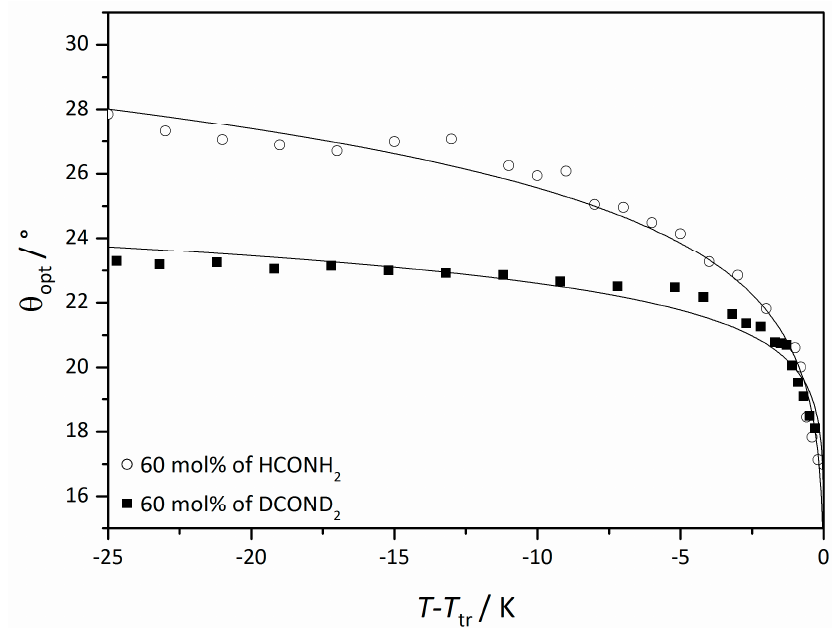
Figure 23. Optically measured tilt angle of the system 4 /formamide (circles) and 4 /deuterated formamide (squares) at the same mole fraction relative to the phase transition temperature T tr from the L α phase. (Reprinted by permission from John Wiley and Sons: [45].)